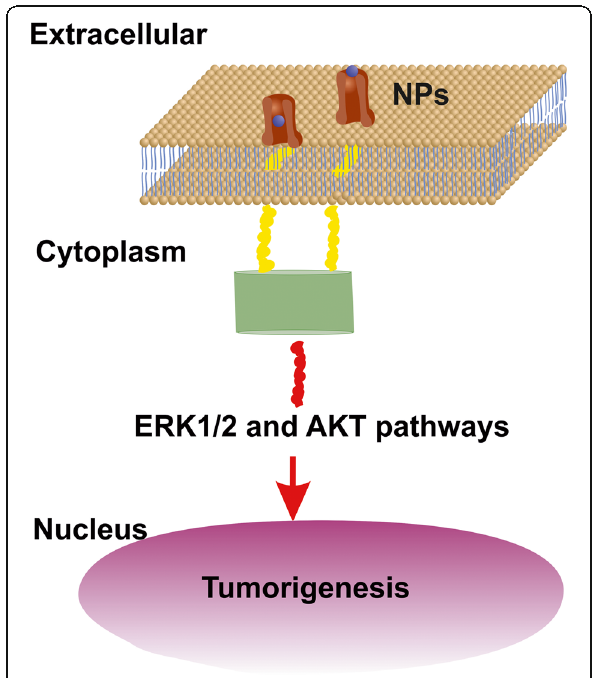
Fig. 12 AKT and ERK1/2 signal transduction pathways activated by RE-NPs via EGFR stimulation. EGFR is activated only by tiny size ~ 5 nm